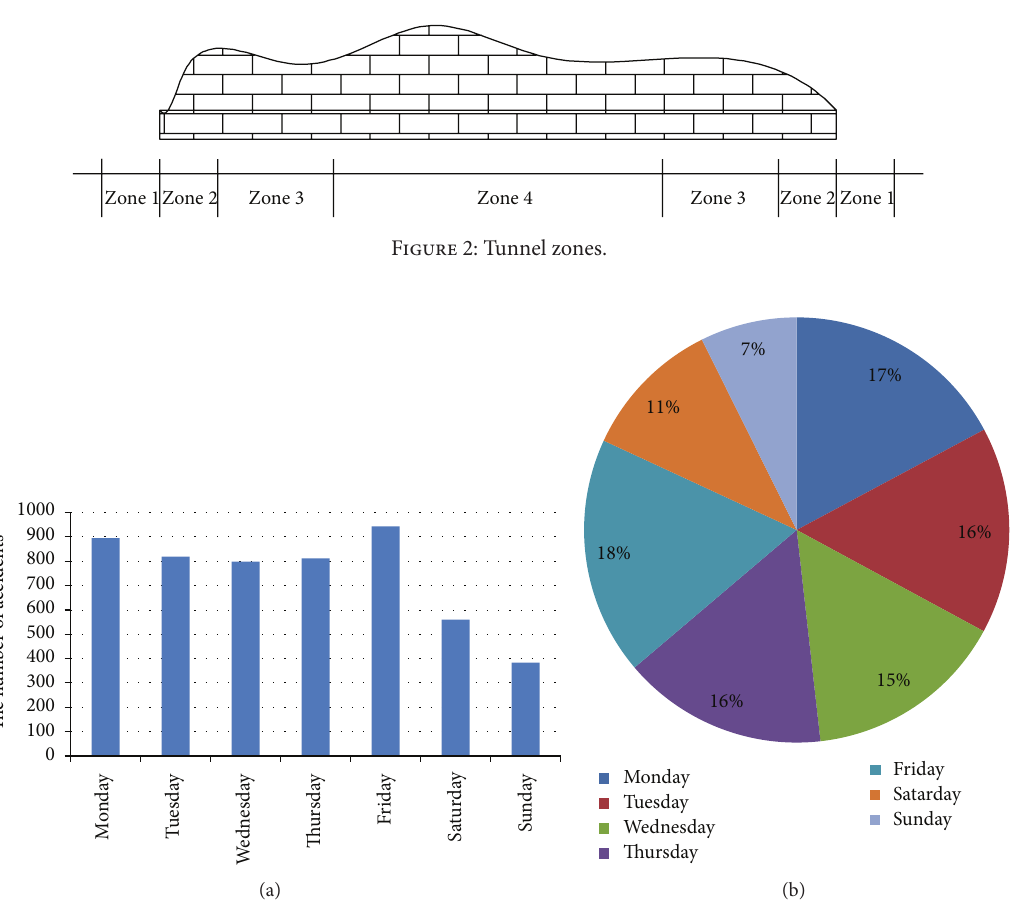
Figure 3: Weekly distributions of traffic accidents.